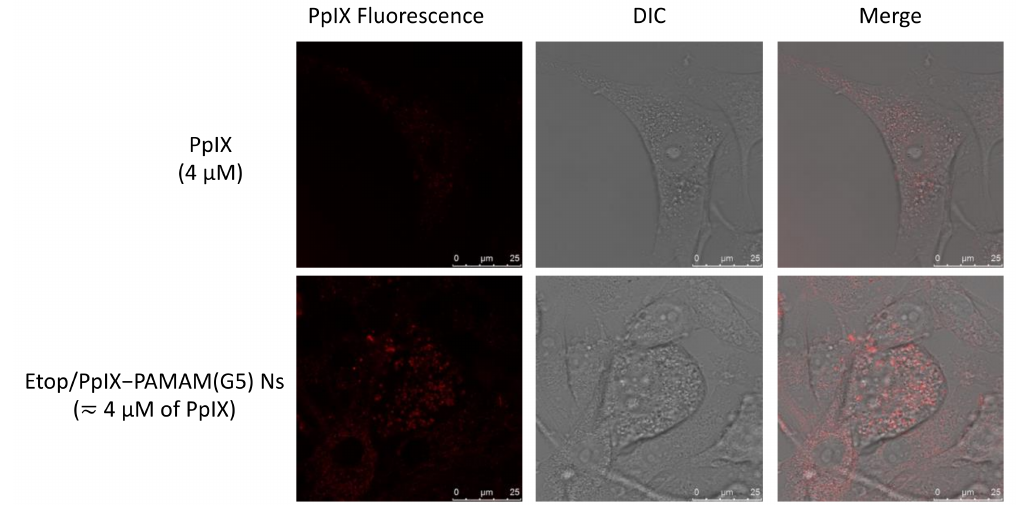
Figure 8. U87-MG cells incubated with PpIX or Etop/PpIX-PAMAM(G5) Ns for 1 h were imaged by confocal microscopy; fluorescence images were taken with the excitation and emission wavelengths for PpIX which were 409 nm and 570 nm, respectively. DIC microscopy images were taken concurrently for image fusion. PpIX fluoresces red on confocal mi- croscopy upon excitation. The intracellular fluorescence was much more evident for Etop/PpIX-PAMAM(G5) Ns than for PpIX, and these appeared to localize as dense granules within the cytoplasm. (DIC—differential interference contrast, Etop—etoposide, PAMAM(G5) Ns—generation-5 polyamidoamine dendrimer nanosphere, PpIX—protoporphyrin IX). The scale bars = 25 µ